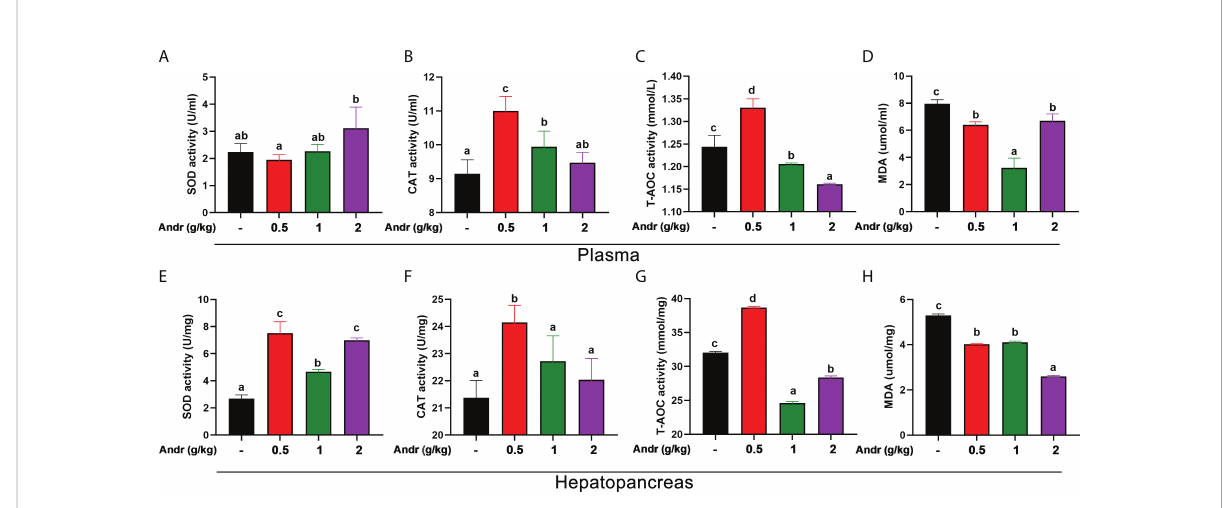
FIGURE 4 Effects of dietary Andr on antioxidative indices in plasma and hepatopancreas of L.vannamei. (A, E) SOD, total superoxide dismutase; (B, F) CAT, catalase; (C, G) T-AOC, total anti-oxidation capacity; (D, H) MDA, malondialdehyde. Values are means ± SD. a,b,c,d Value bars not sharing the same superscript letter are signi fi cantly different as evaluated by Duncan ‘ s test ( p <